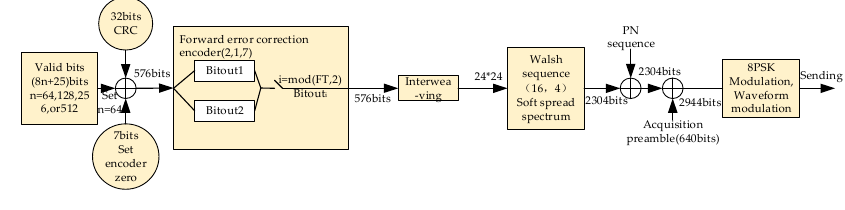
Figure 5. The transmission scheme of burst waveform BW3.